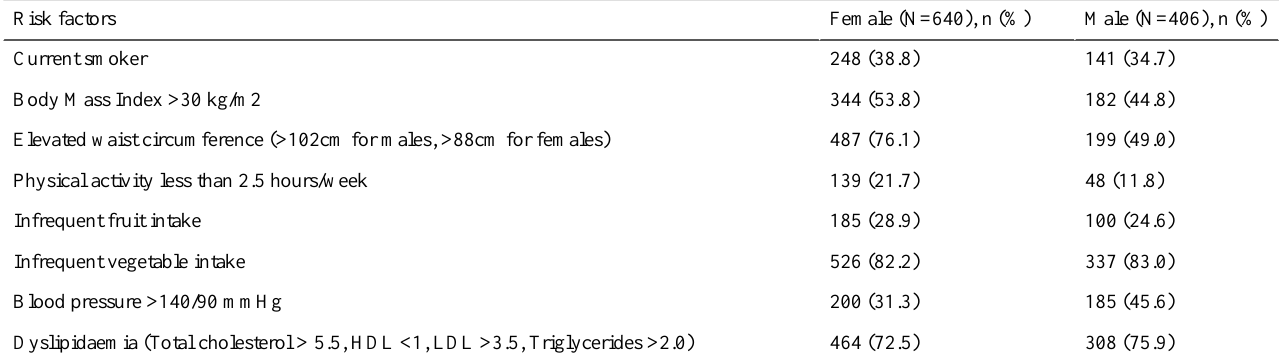
Table 3. Chronic disease risk factors by